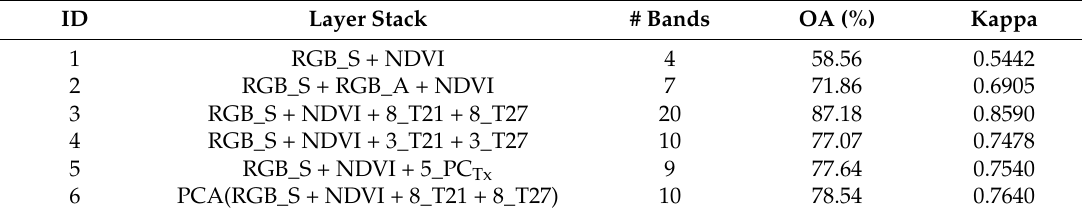
Table 6. OA of different layer stacks, classified by the Maximum Likelihood algorithm.